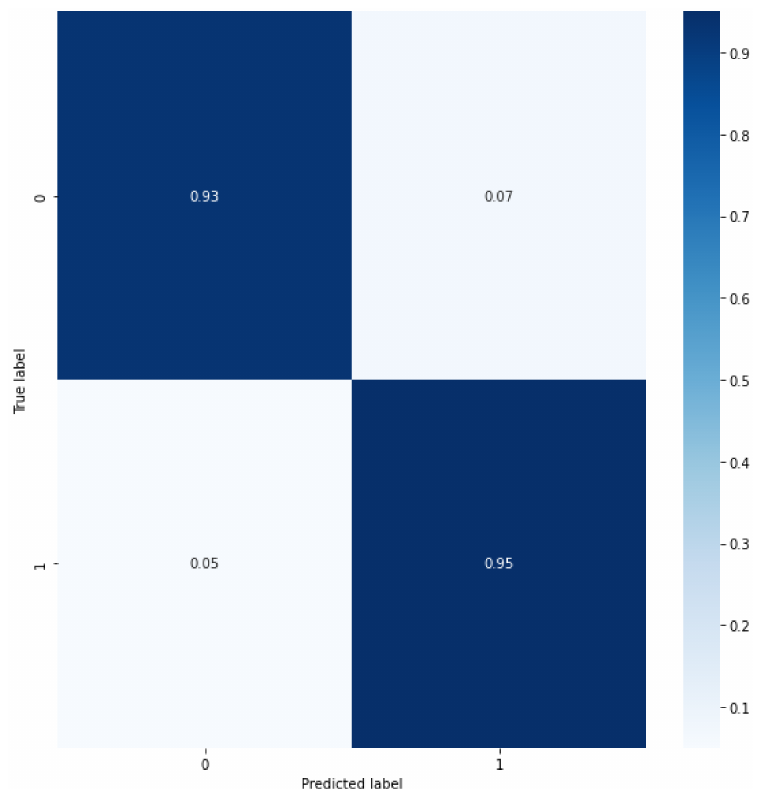
Figure 15. The result of the confusion matrix CNN. Table 8. The experiment results of the CNN model in every aspect of sentiment